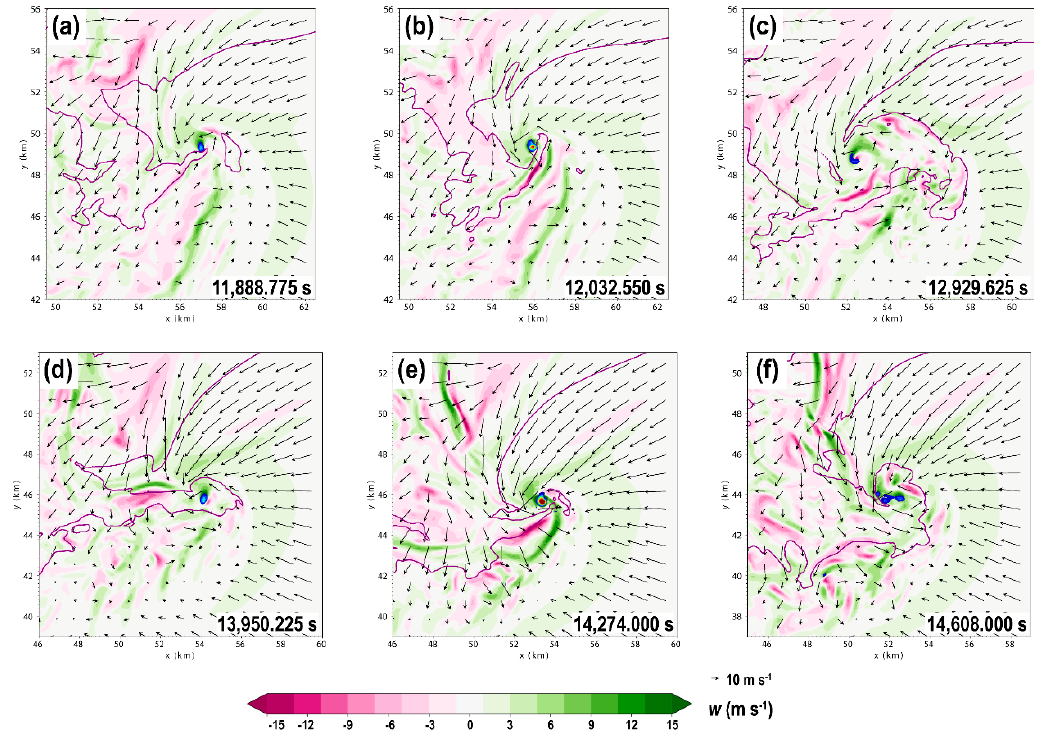
Figure 4. Vertical velocity field (light shading; m s − 1 ) throughout the life cycle of the simulated tornadoes at ( a ) 11,888.775 s, ( b ) 12,032.550 s, ( c ) 12,929.625 s, ( d ) 13,950.225 s, ( e ) 14,274.000 s, and ( f ) 14,608.000 s (compare with Figure 2d–i and Figure 3a–i). Horizontal wind (vectors; m s − 1 ) and the 0.3 g kg − 1 rainwater mixing ratio contour are also plotted. Pockets of strong vertical vorticity associated with the tornadoes in the center of the domain are shaded in the foreground, starting at 0.1 s − 1 . All fields at 158 m AGL.